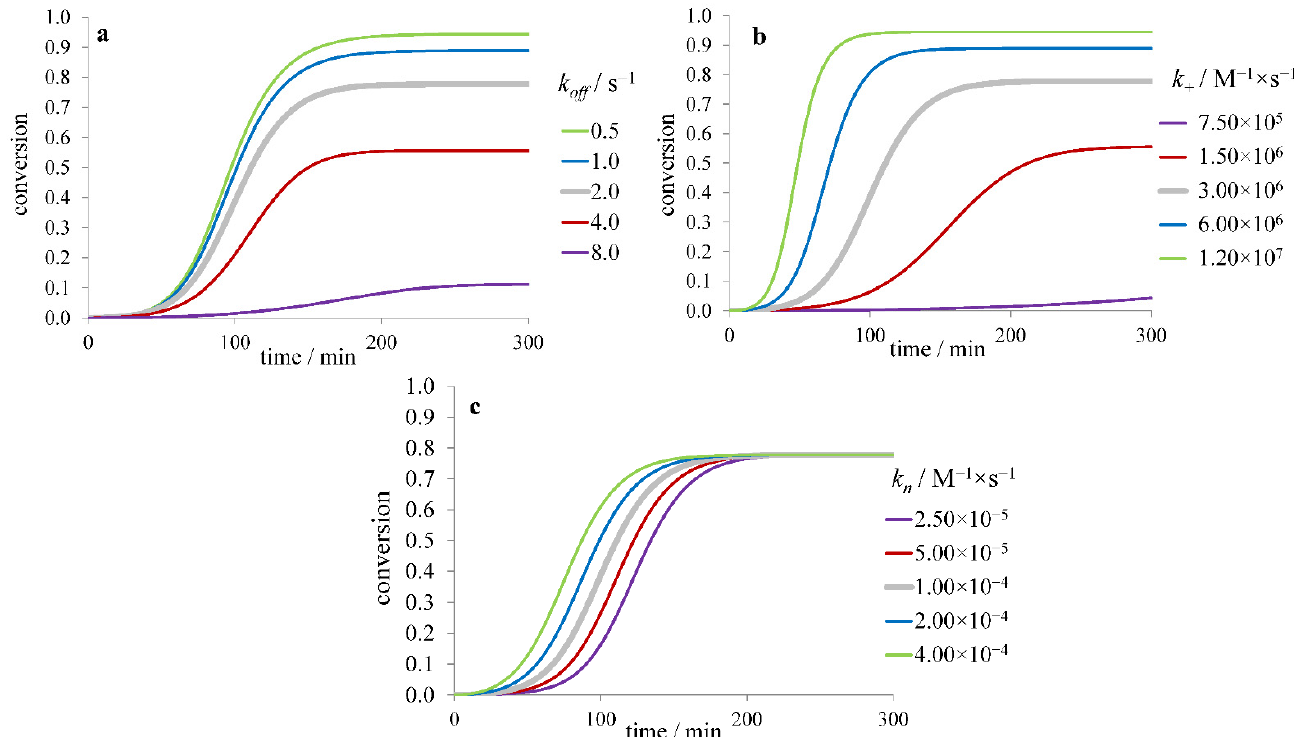
Figure 6. Dependence of the time course on ( a ) depolymerization ( k off ), ( b ) nucleation ( k n ), ( c ) elongation ( k + ), rate constant for the model of reversible fibril formation with secondary nucleation.